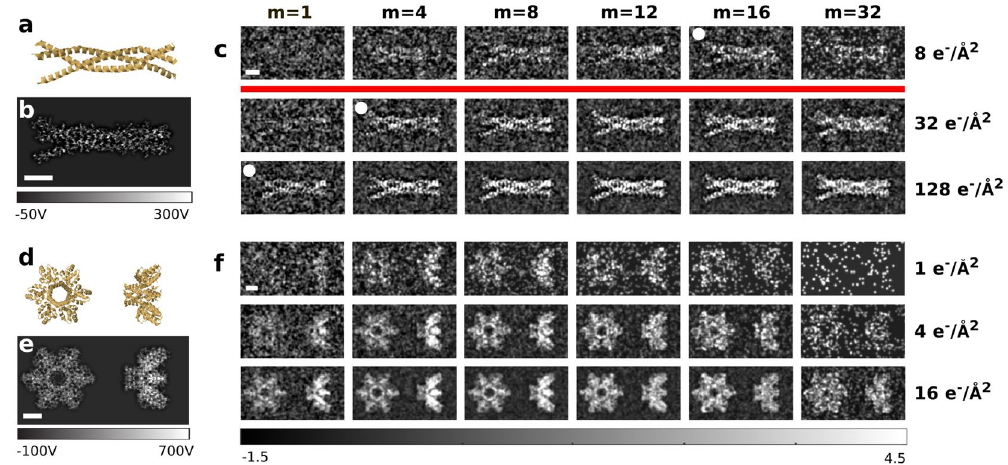
Figure 3. Multi-pass TEM simulation of protein structures. ( a ) Shows the ribbon diagram and ( b ) shows the projected potential of MARV VP35. ( c ) Shows simulated multi-pass phase TEM images for 300 keV electrons, calculated at three respective levels of effective dose, which are shown on the right. Note that the incoming dose for each panel is roughly m -fold lower than the effective dose, as explained in the text. The white circles indicate figures of similar SNR (see text). The red line indicates the typical critical dose (~20 e − /Å 2 ) for biological specimens 23 . ( d–f ) Show the results for two different projections of HIV–1 Gag. All scalebars are 2 nm, the colorscale for ( c ) and ( f ) is in units of standard deviations from the mean intensity of each